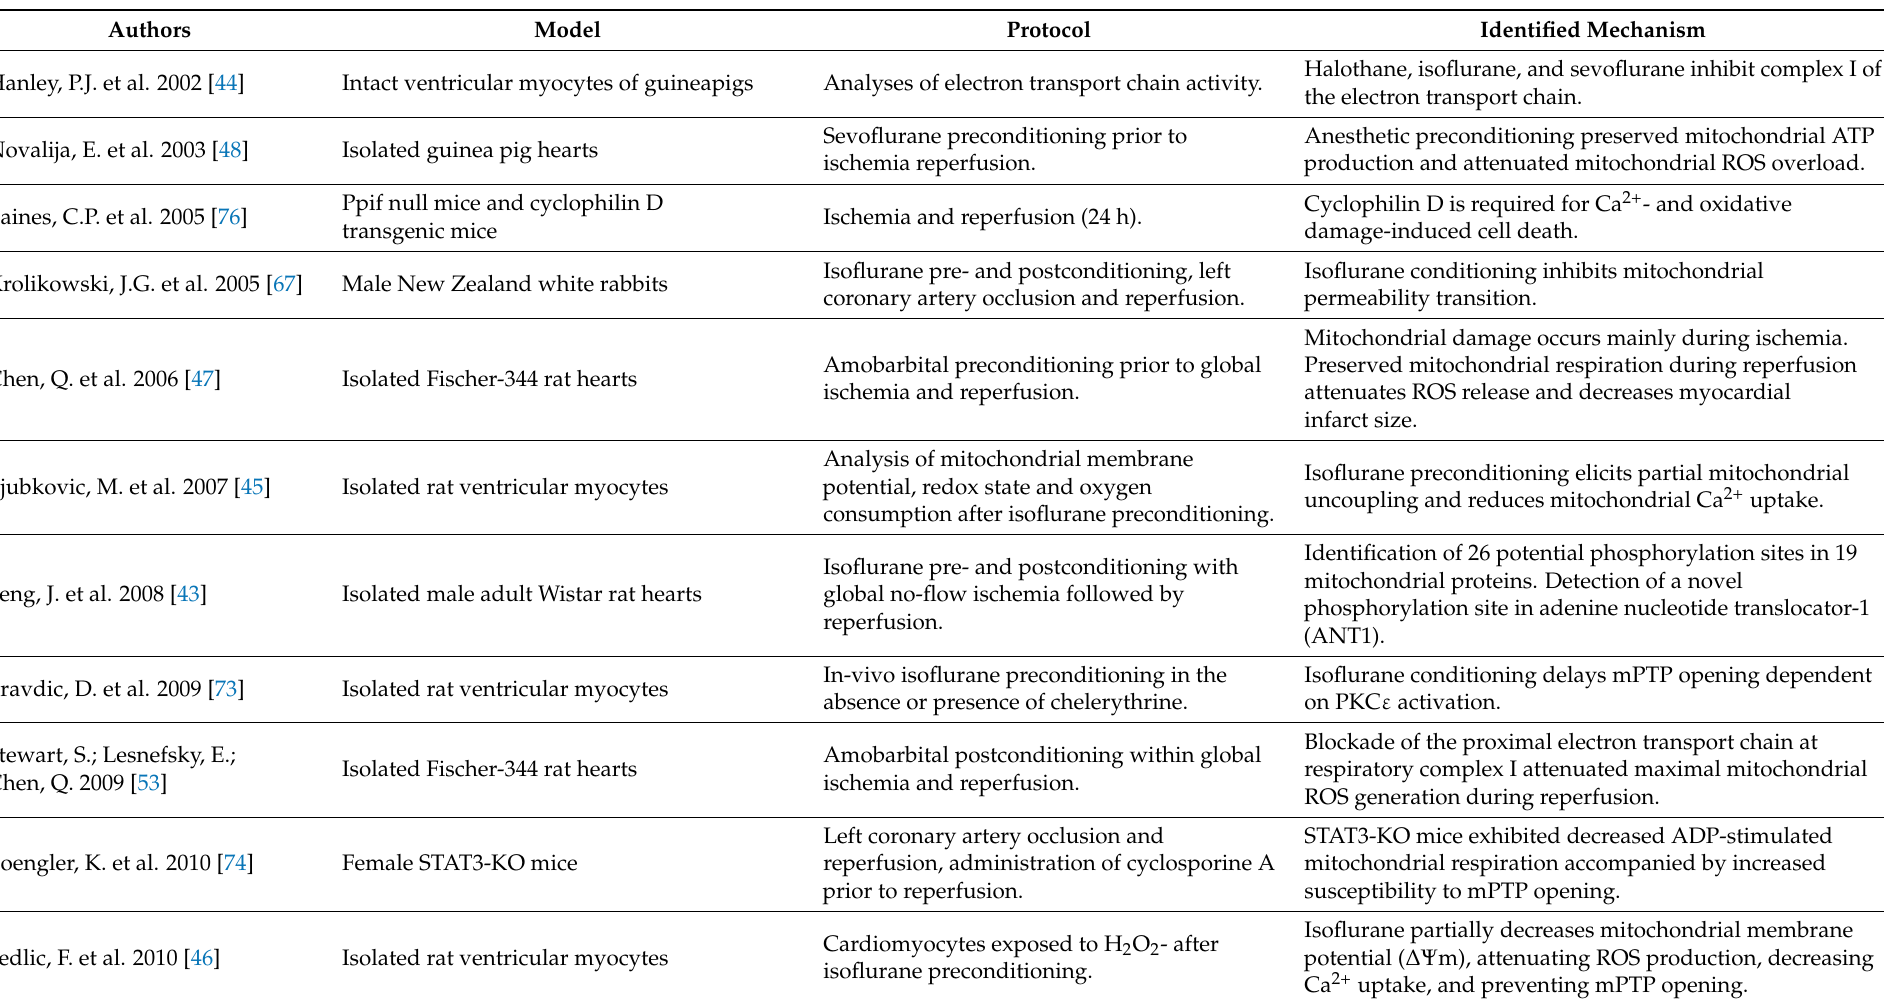
Table 1. Selected studies related to mitochondrial mechanisms of cardiac